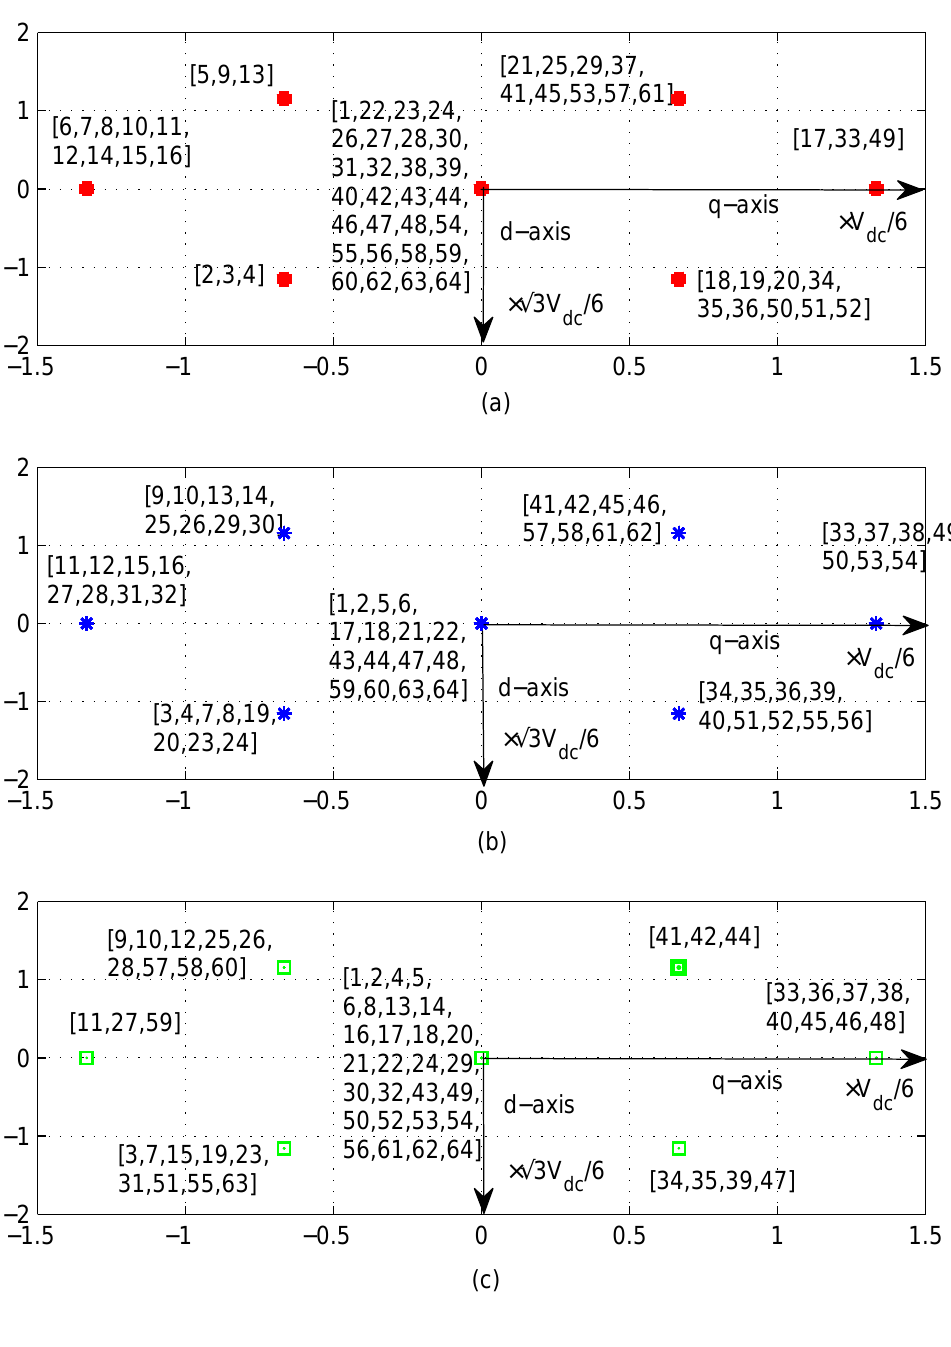
times. In the proposed PWM method, for generality, it is as- sumed that all 4( N + 1 = 4) zero states are used in synthe- sizing the reference voltages. The dwell time for the zero